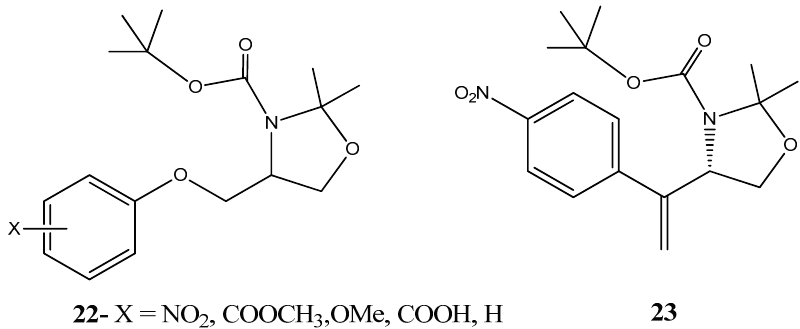
Figure 13. Chemical structure representation of 2,3,4-trisubstituted oxazolidines core scaffold ( 22 ) and oxazolidine derivative, ( S )-tert-butyl 2,2-dimethyl-4-(1-(4-nitrophenyl)vinyl) oxazolidine-3-carboxylate ( 23 ) with proven anticancer activity against HL60, JURKAT, MDA-MB-231 and LNCaP